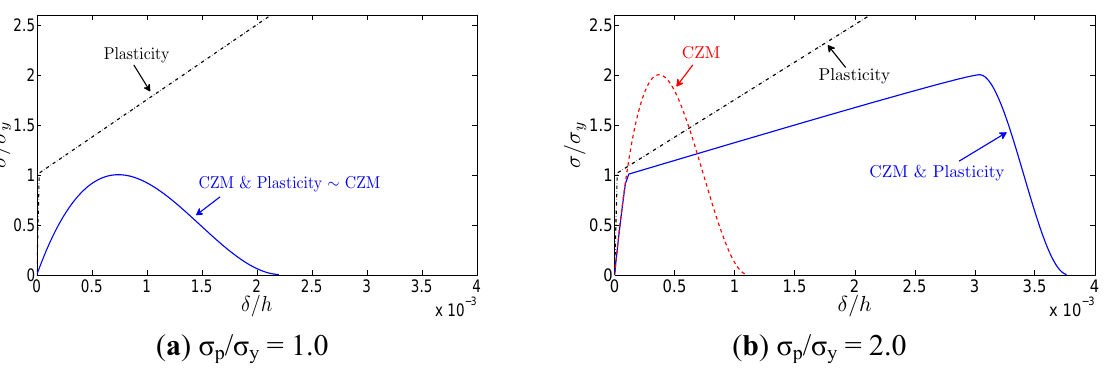
Figure 4. Basic interplay between CZM and plasticity: elasto-plastic with hardening constitutive law and nonlinear CZM. ( a ) Fracture for σ ( b ) fracture for σ / σ > 1, as for ductile p y